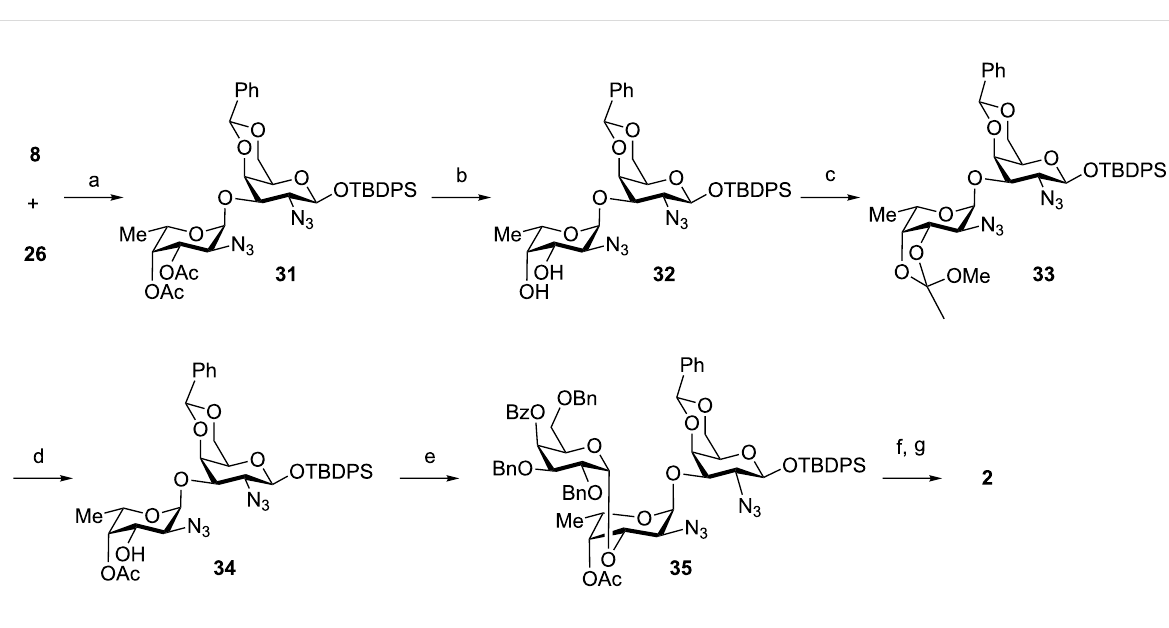
removal of the anomeric TBDPS silyl ether using HF-pyridine and subsequent treatment with trichloroacetonitrile in the pres- ence of catalytic amounts of DBU to afford glycosyl trichloro- acetimidate trisaccharide 2 (Scheme